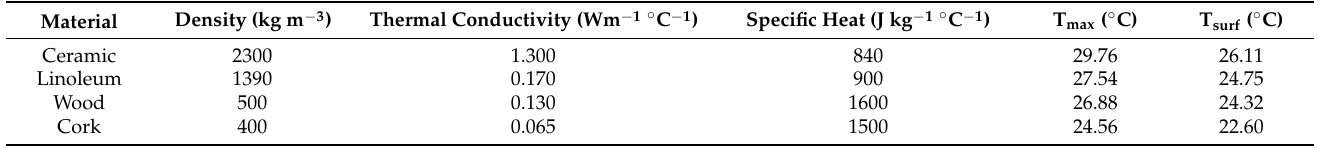
Table 3. Properties of the finishing materials and simulation